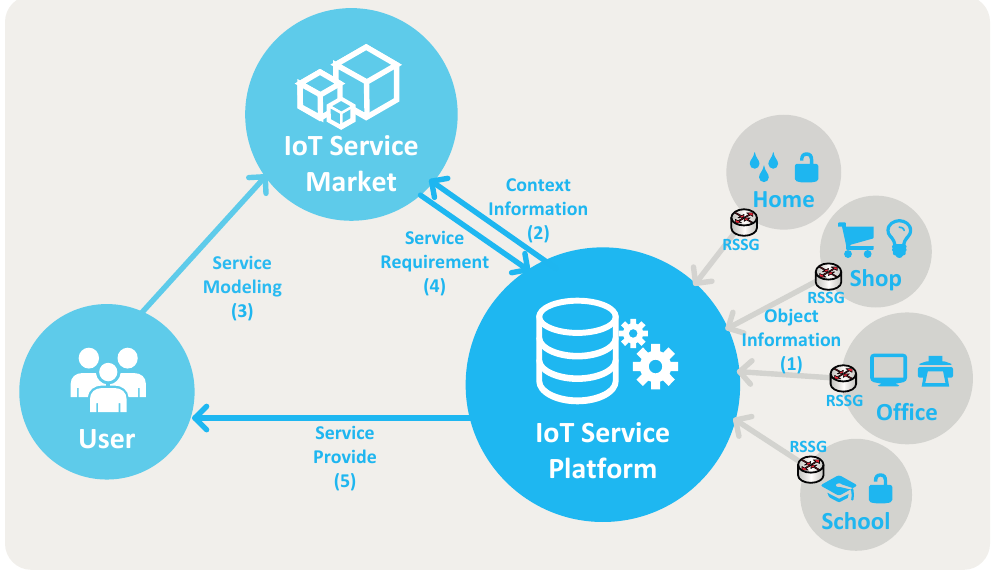
Figure 1. Overview of the IoT-based user-driven service